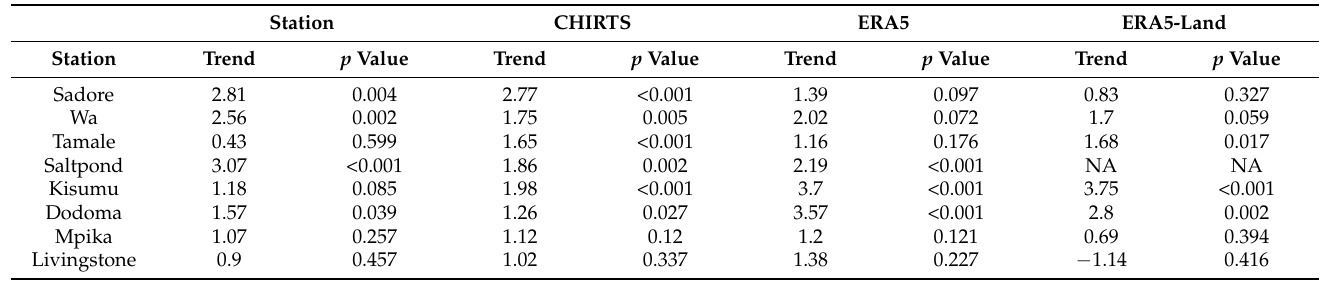
Table 7. Annual mean maximum temperature trend per 100 years ( ◦ C) and corresponding p value for station data and the three gridded products.